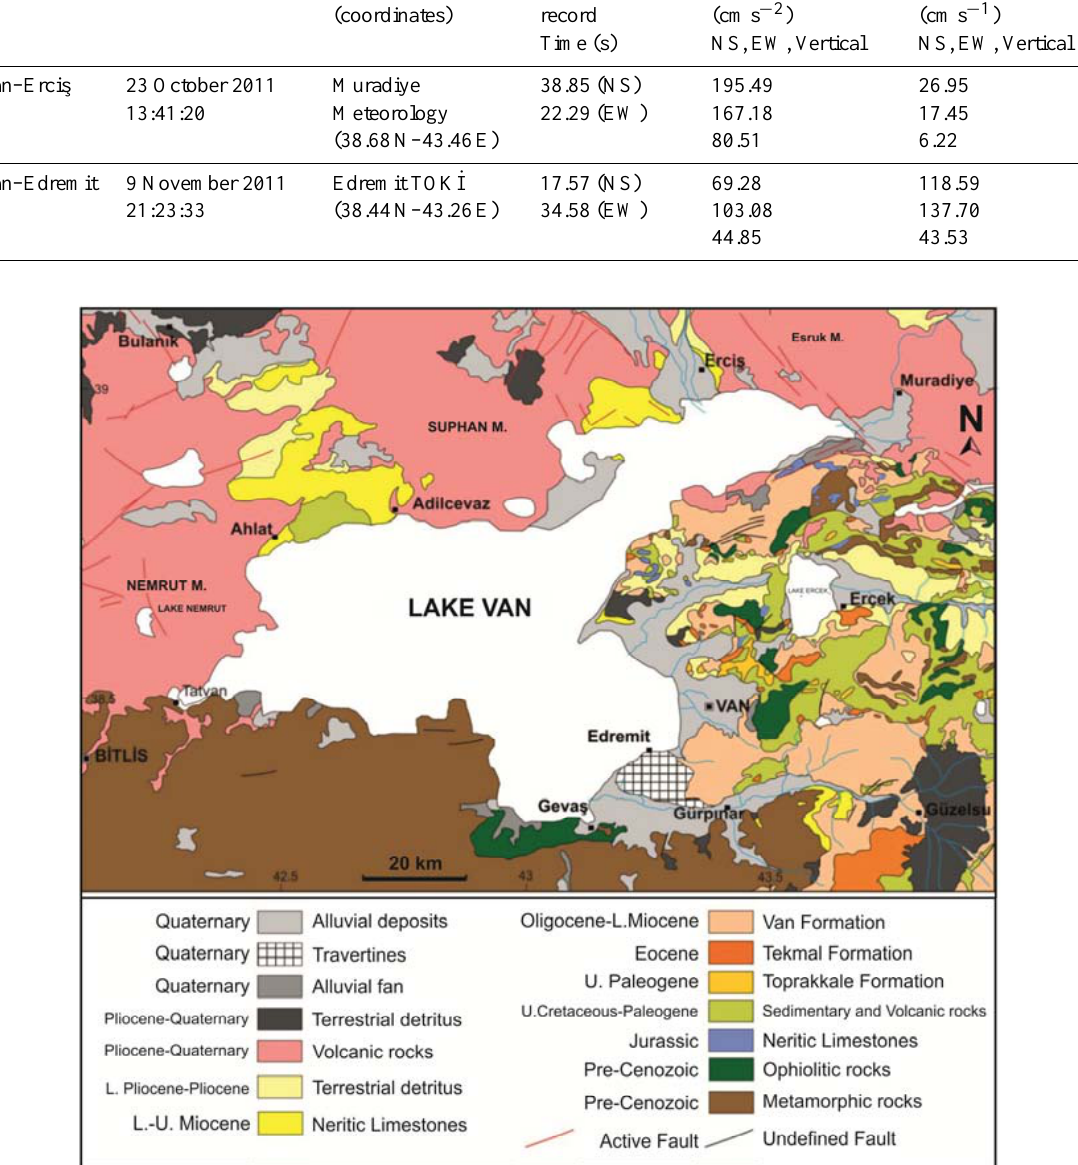
Table 2. Characteristics of earthquake records used for the evaluation of Van earthquakes ( ¨Onen et al., 2011). Earthquakes